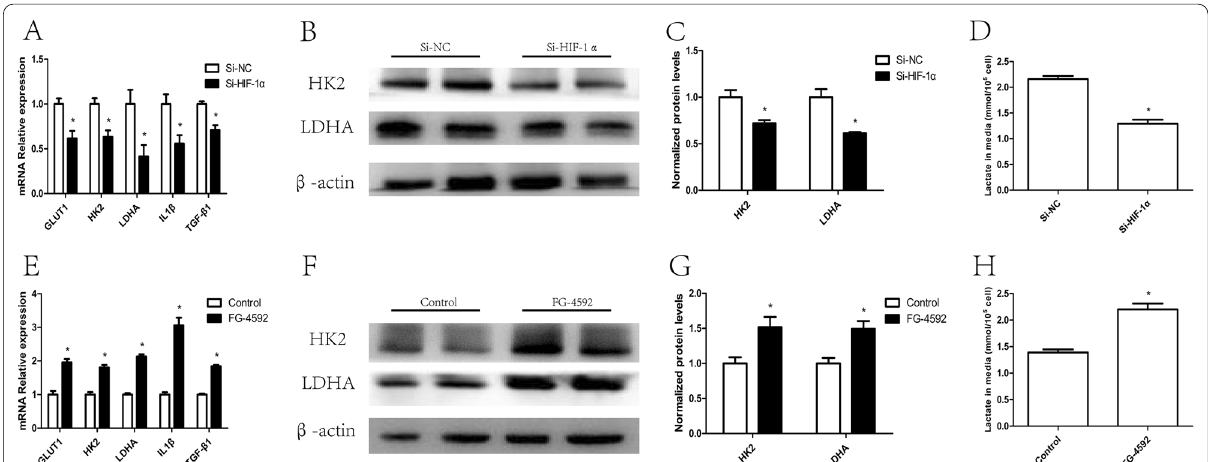
Fig. 5 HIF-1α promoted macrophage glycolysis. Macrophages were transfected with HIF-1α siRNA: A mRNA levels of GLUT1, HK2, LDHA, IL1β and TGF-β1 (n 3); B , C protein levels of HK2 and LDHA (n = group. Macrophages were treated with FG-4592: E mRNA levels of GLUT1, HK2, LDHA, IL1β and TGF-β1 (n (n 4); H amount of lactate in the macrophage supernatant (n =